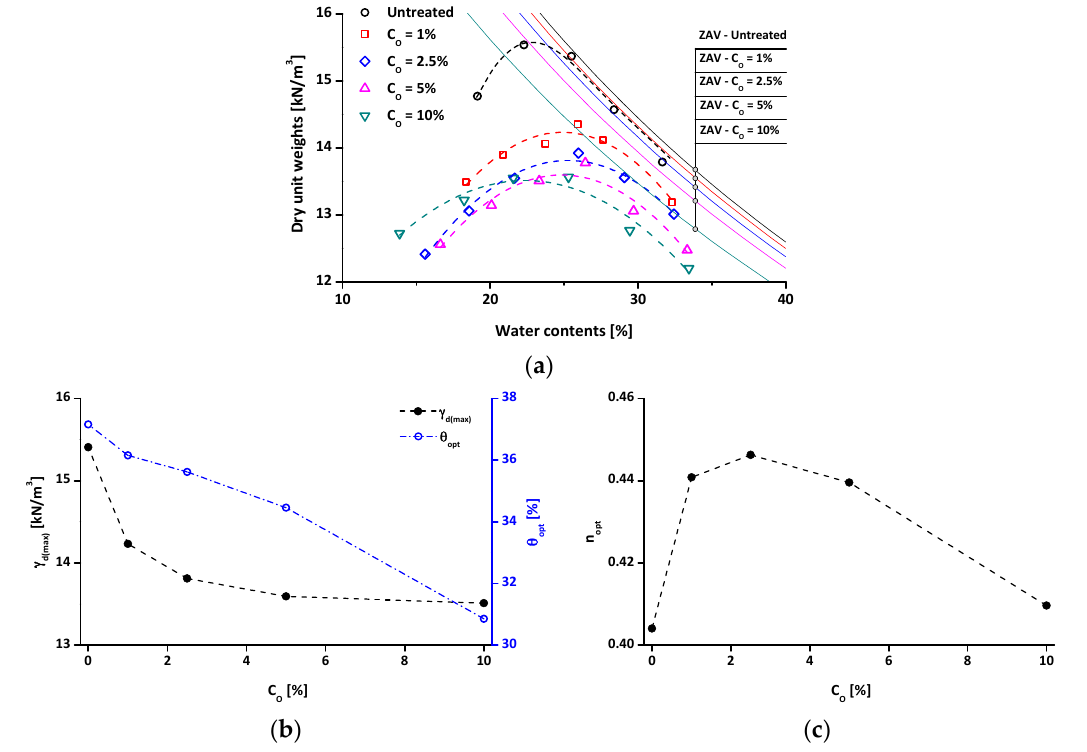
Figure 8. Compaction results: ( a ) compaction curves with zero air voids (ZAV) curves; ( b ) maximum dry unit weights ( γ d(max) ) and optimum volumetric water contents ( θ opt ); and ( c ) porosity at γ d(max) (n opt ) with the treatment concentration (C O